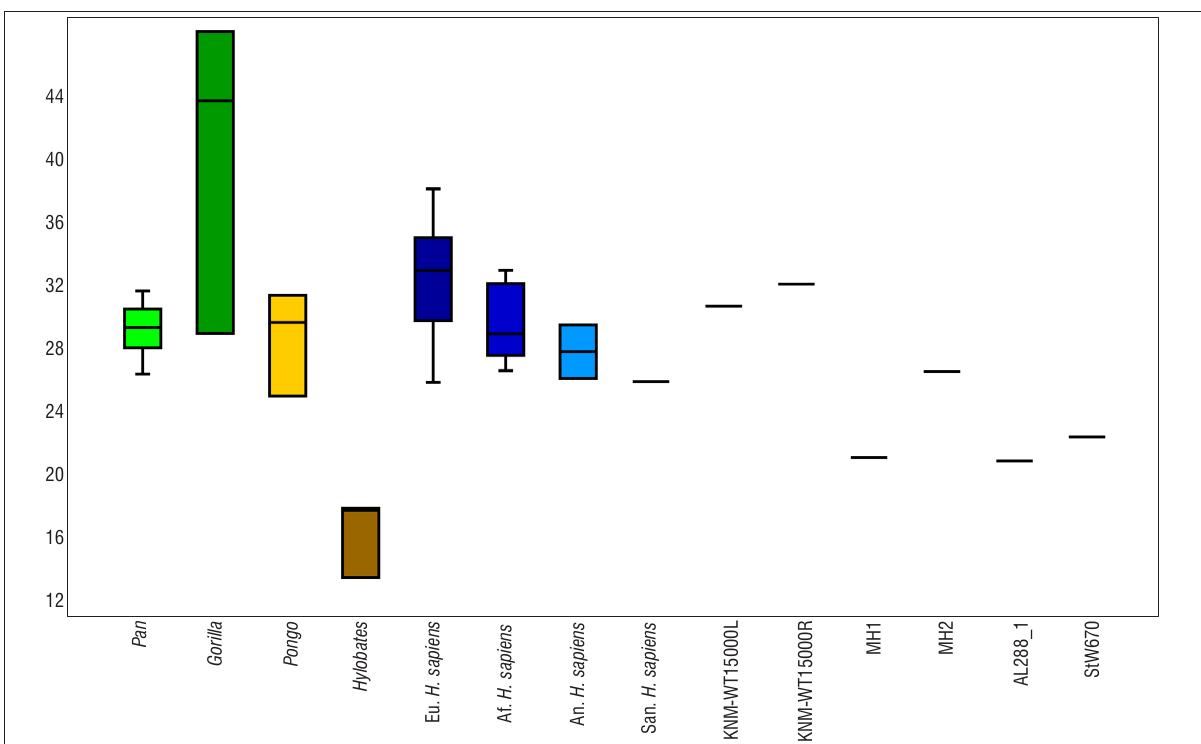
Eu, European; Af, African; An, Andaman Figure 5: Centroid size distribution of StW 670 compared to first ribs in the comparative sample. StW 670 centroid size is smaller than that of Homo erectus (KNM-WT 15000, both antimeres), the great apes ( Pan, Pongo and Gorilla) and H. sapiens (including small-bodied ones); bigger than that of Hylobates; and is located between the centroid sizes of the two Australopithecus species ( A. afarensis AL 288-1 and A. sediba MH1). Comparative extant sample sizes are listed in Supplementary table 1.